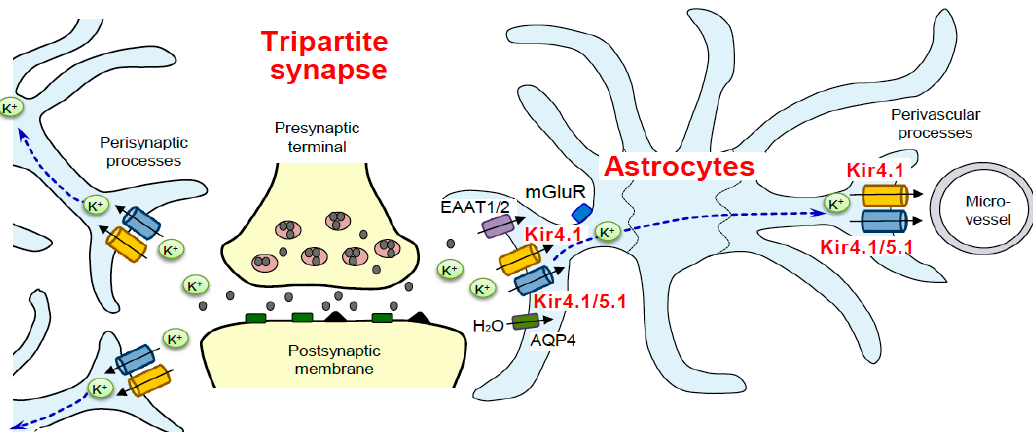
Figure 2. Kir4.1 channels mediate the spatial K + buffering action of astrocytes. The spatial K + buffering action of astrocytes is essential for controlling extracellular K + concentrations at tripartite